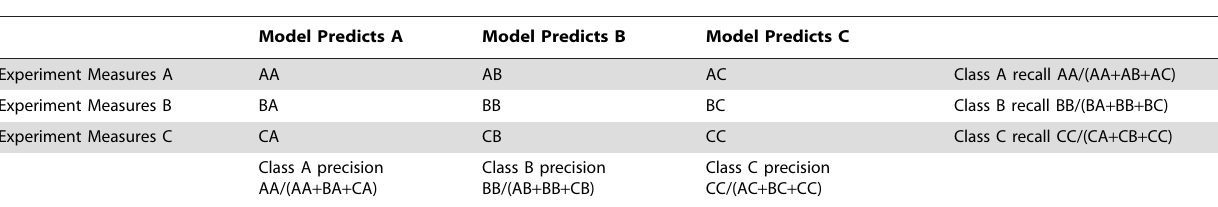
Table 6. Ternary classification confusion